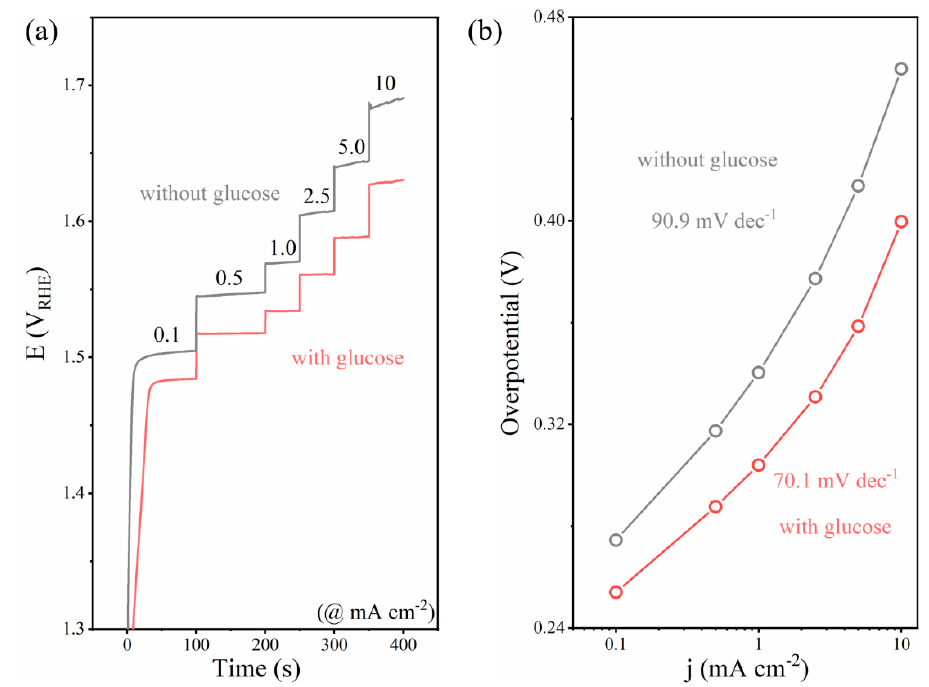
Figure 3. ( a ) The steady-state galvanostatic measurement and ( b ) the corresponding Tafel plots of both types of FeCoNiCuIr HEA NPs, which were obtained at current densities of 0.1, 0.5, 1, 2.5, 5, and 10 mA cm − 2 in N 2 -saturated 1 M KOH.